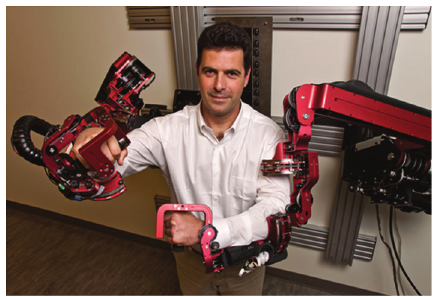
Figure 19: EXO-UL7. Reprinted with